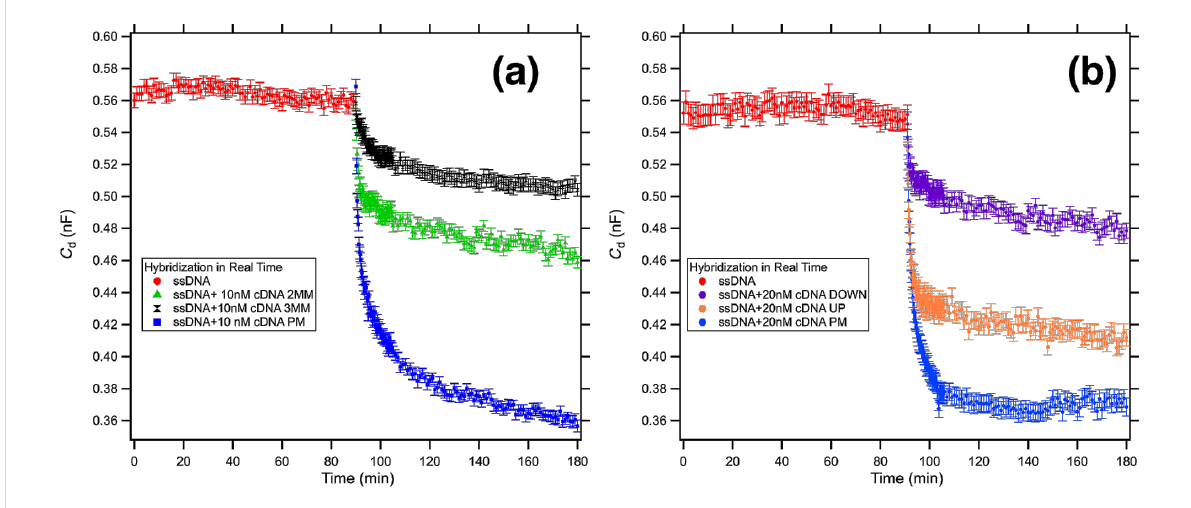
Figure 4: Differential capacitance measurements of the kinetics of DNA hybridization in presence of multiple mismatches (a) and in presence of partially complementary sequences (b). The red signal represents the differential capacitance of a low-density 44 bases ssDNA SAM functionalized WE measured in 100 mM KCl. (a) In blue we report the hybridization with the fully matching sequence, in green the hybridization with a sequence with 2 MMs, and in black the hybridization with a sequence with 3 MM. (b) In blue we report the hybridization with the fully matching sequence, in orange the hybridization with a 22mer sequence complementary with the upper part (far from the gold surface) of the target and in purple the hybridization with a 22mer sequence complementary with the lower part (close to the gold surface) of the